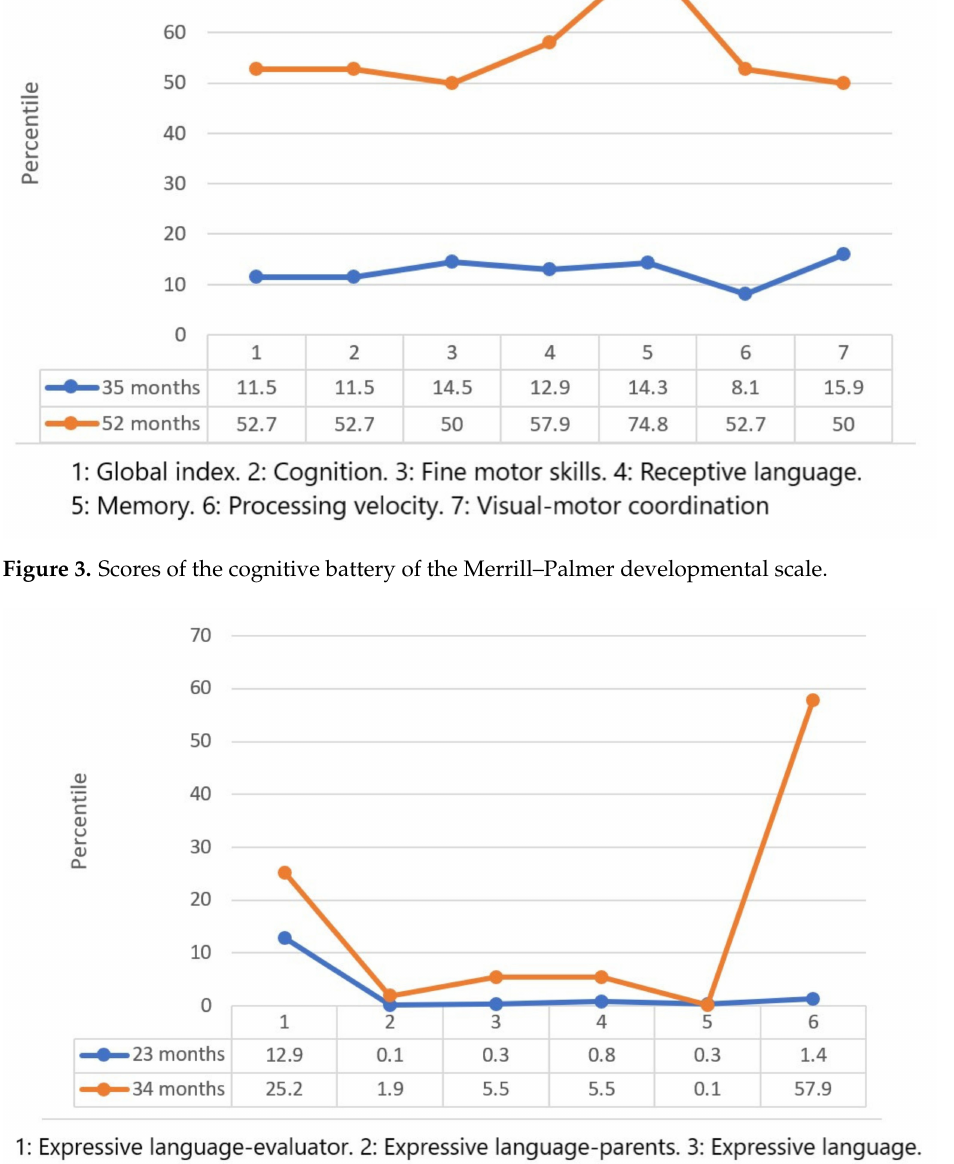
Figure 4. Scores for language areas, social–emotional and adaptive behavior, and self-care on the Merrill–Palmer Developmental